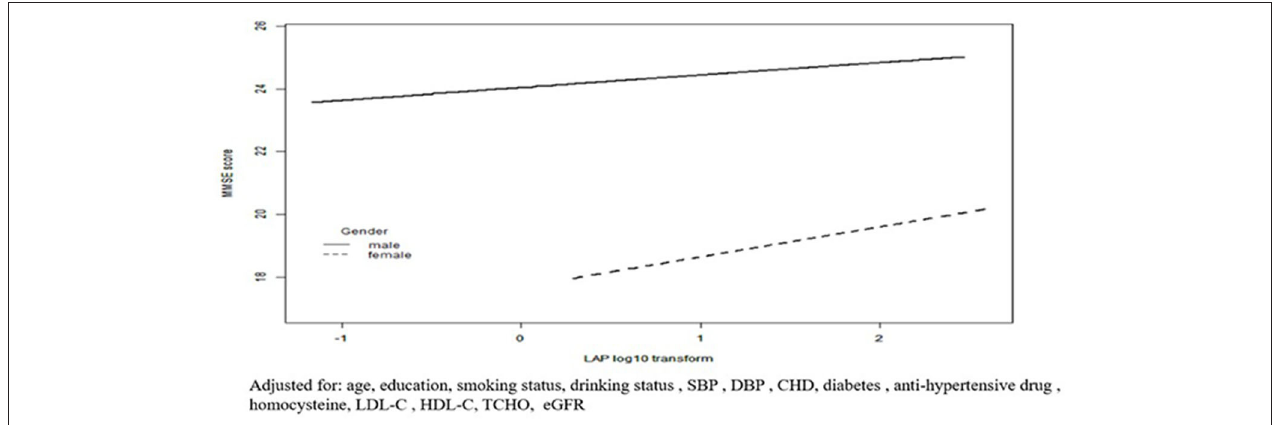
FIGURE 2 | Fitted curves for LAP index as a common logarithm-transformed continuous variable and cognitive function represented by MMSE scores. Adjusted for: age, education, smoking status, drinking status, SBP, DBP, CHD, diabetes, anti-hypertensive drug, homocysteine, LDL-C, HDL-C, TCHO,